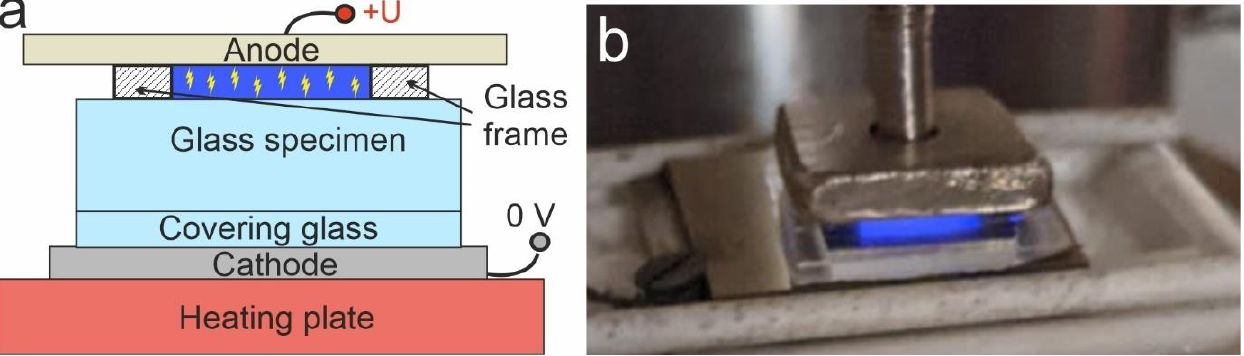
Figure 1. Scheme ( a ) and an actual photo ( b ) of the poling setup with glowing plasma under 1300 V applied.